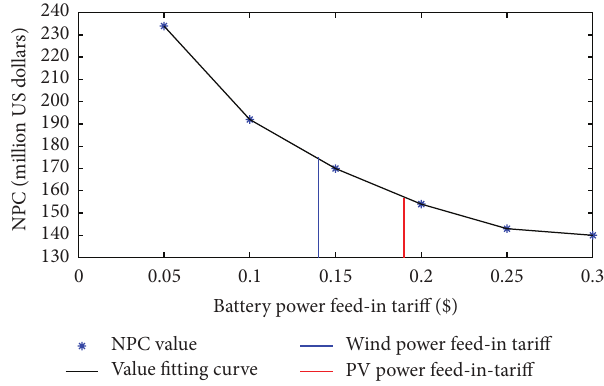
Figure 11: Impact of the feed-in tariff of battery